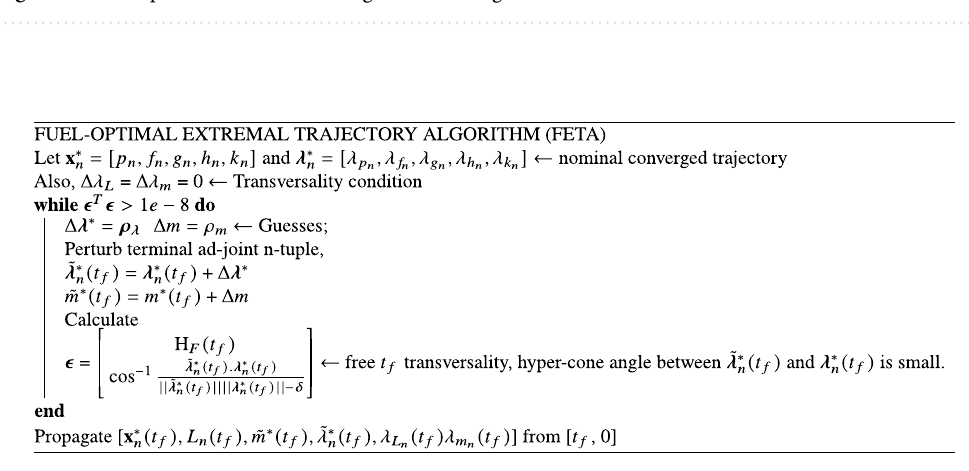
Figure 4. Fuel-optimal extremal bundle generated using FETA: N